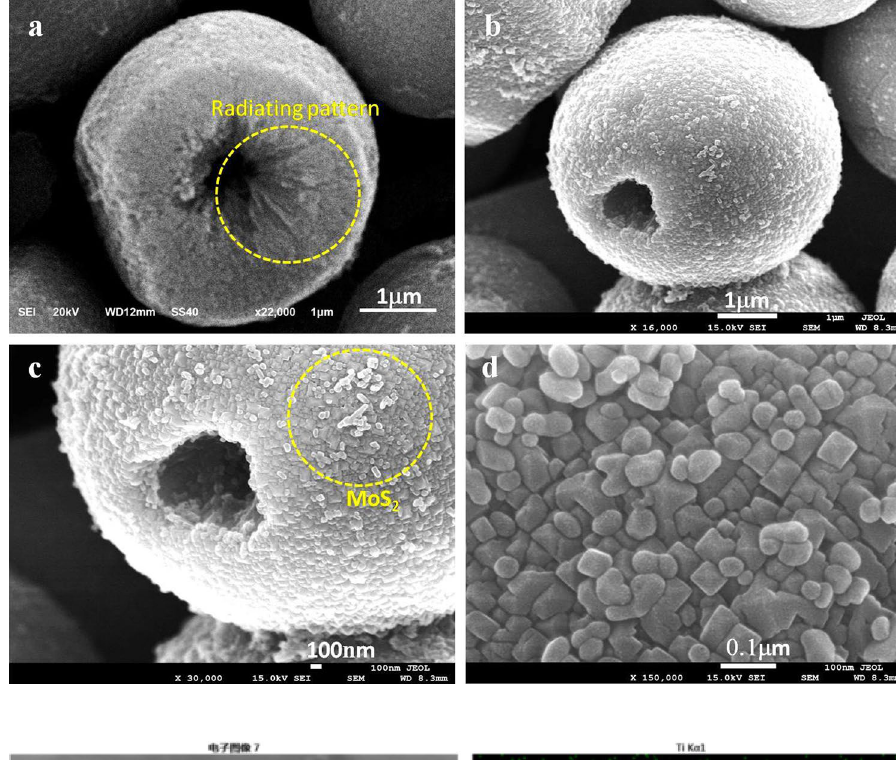
Fig. 3 Energy-dispersive X-ray spectroscopy studies of 5 MST sample showing the presence of Ti, O and